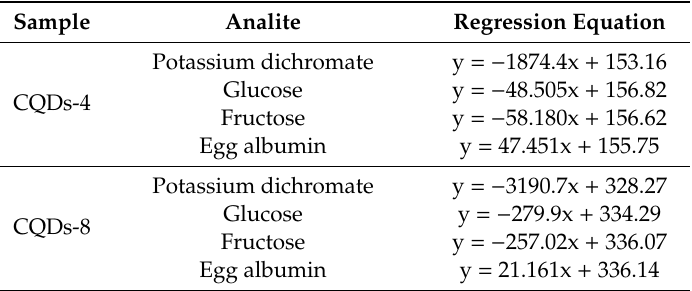
Table 2. Coumarin-modified CQD sensing sensitivity.